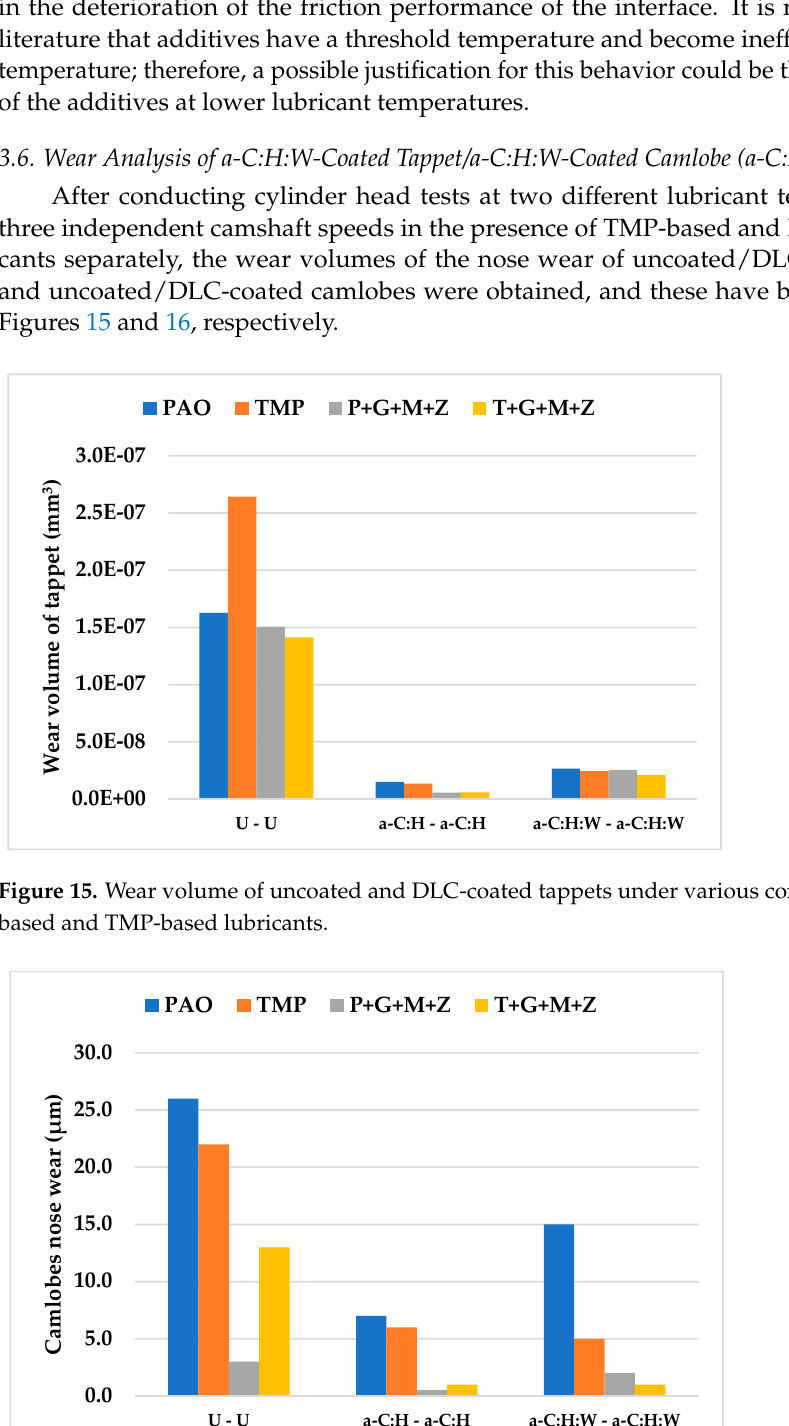
Figure 14. Average friction torque of exhaust camshafts with a-C:H:W-coated tappets and a-C:H:W-coated camlobes at camshaft speeds of 400 RPM, 800 RPM, and 1200 RPM and lubricant temperatures of ( a ) 40 °C and ( b ) 90 °C.